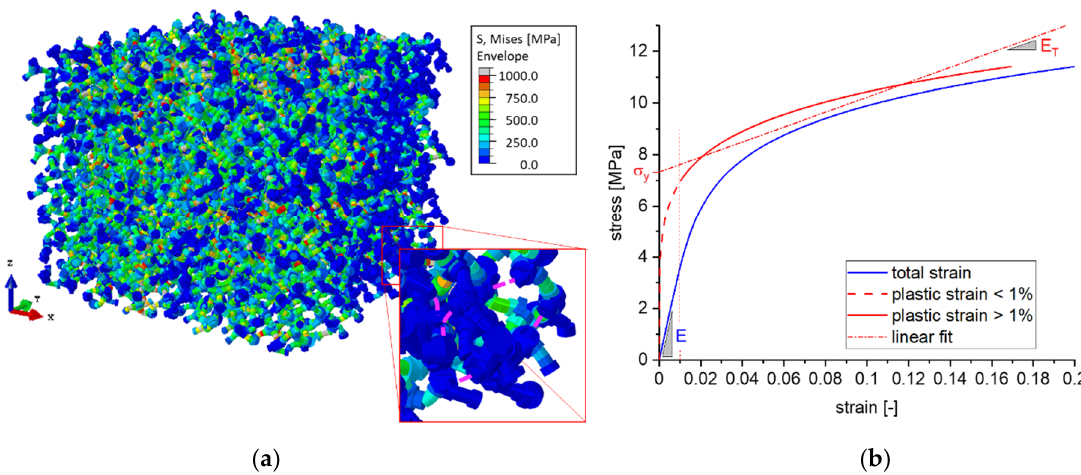
Figure 2. ( a ) RVE consisting of 8 × 8 × 8 unit cells with A = 18% and ζ = 26% after compression with 20% strain in negative z-direction. The purple dashed curves in the magnified image shown on the right side indicate the axis of some cut ligaments. Due to the missing load transmission, the remaining dangling parts show zero stress (blue color). ( b ) Simulation output in the form of stress–strain and stress–plastic strain curves from which the macroscopic yield stress and work hardening rate are determined.